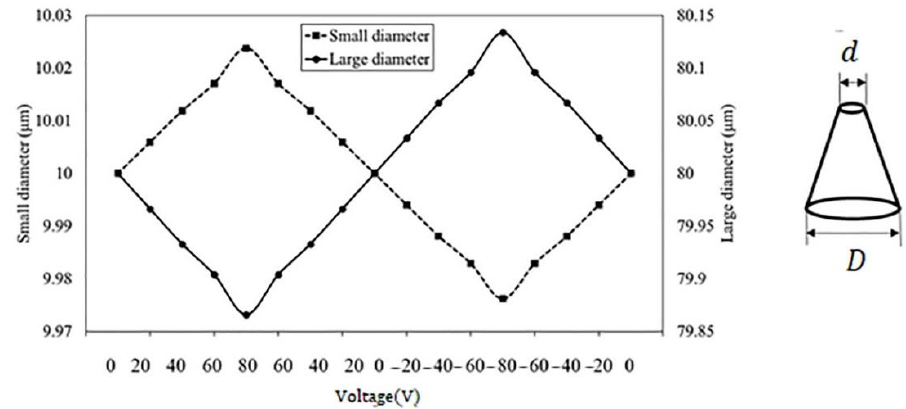
Figure 14. FEM estimation of the maximum micro-aperture variations as a function of the cycling changes in the applied voltage.